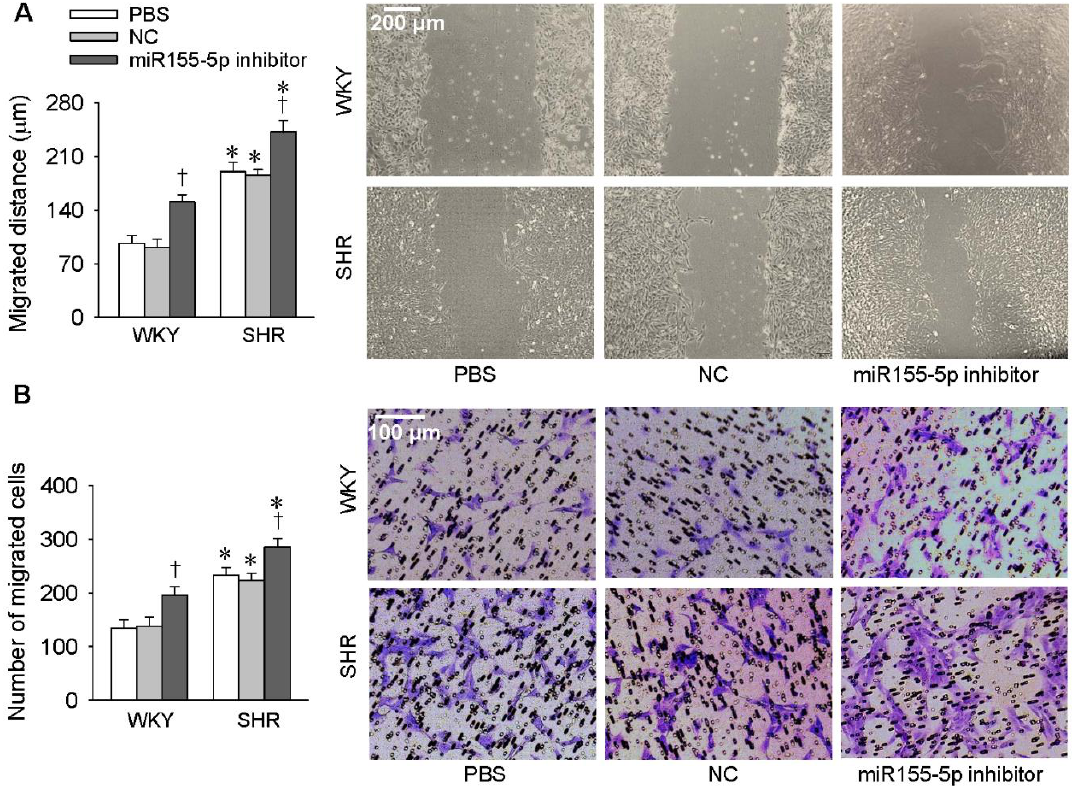
Figure 2. Effects of the miR155-5p inhibitor on VSMC migration. VSMCs from WKY rats and SHR were treated with PBS, negative control (NC), or the miR155-5p inhibitor (50 nmol/L). Measurements were made 24 h after transfection. ( A ) VSMC migration evaluated by a wound healing assay. ( B ) VSMC migration evaluated by the Boyden chamber assay. Values are mean ± SE; * p < 0.05 vs. WKY; † p < 0.05 vs. PBS or NC; n = 6 per group.